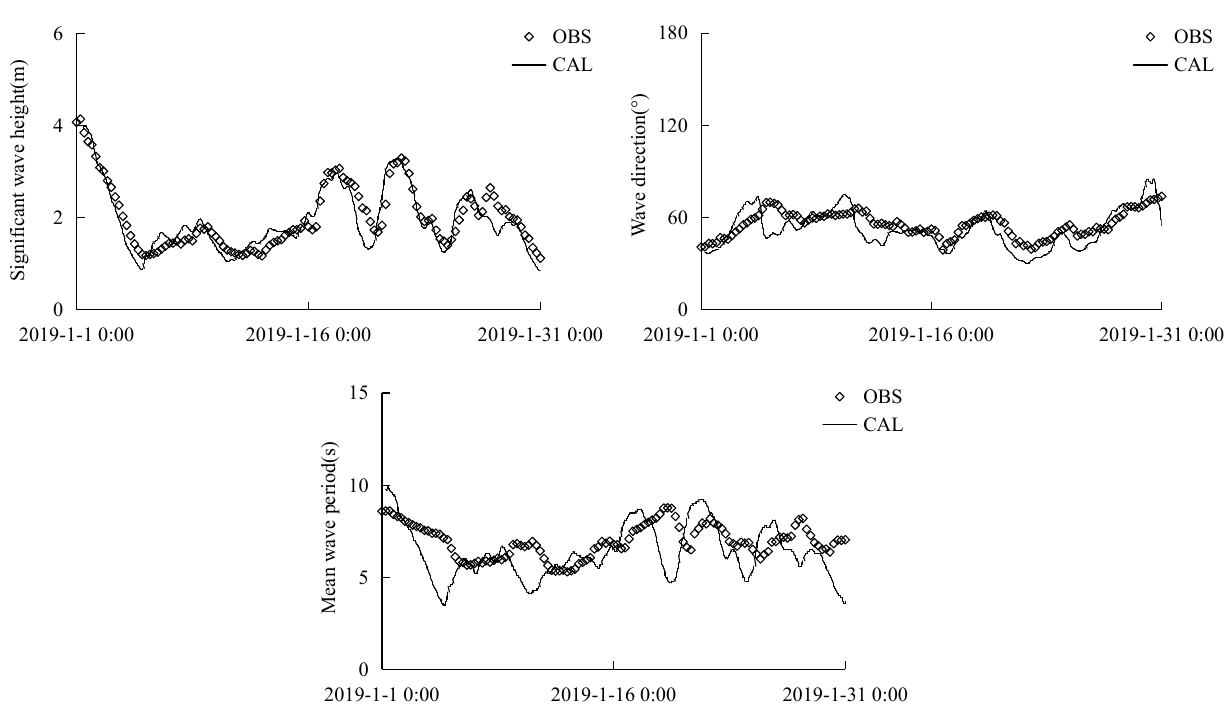
Figure 5. Verification results of wave series at position C.